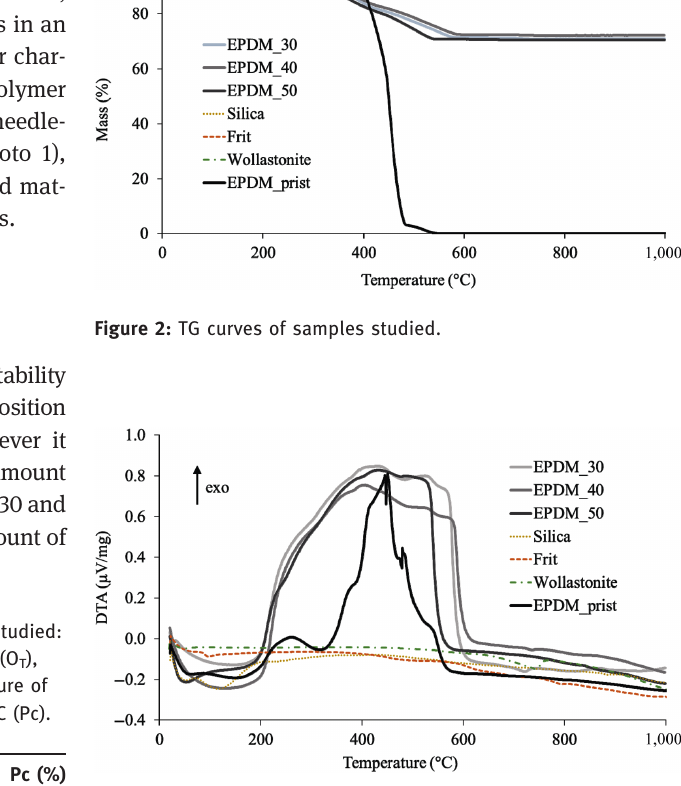
Figure 3: DTA curves of samples studied.